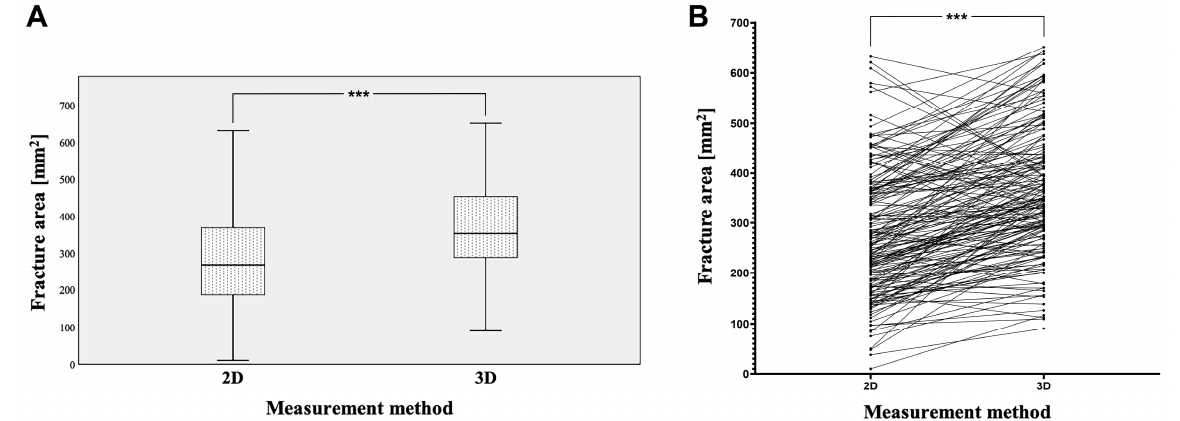
Figure 3. Using 2D and 3D measurement techniques, the calculated fracture areas ( A ) and connecting lines between individual measurements ( B ), with a statistically highly significant difference (*** p < 0.001). Table 2. Fracture areas analyzed based on 2D- and 3D-based measurement methods and the difference between the two.